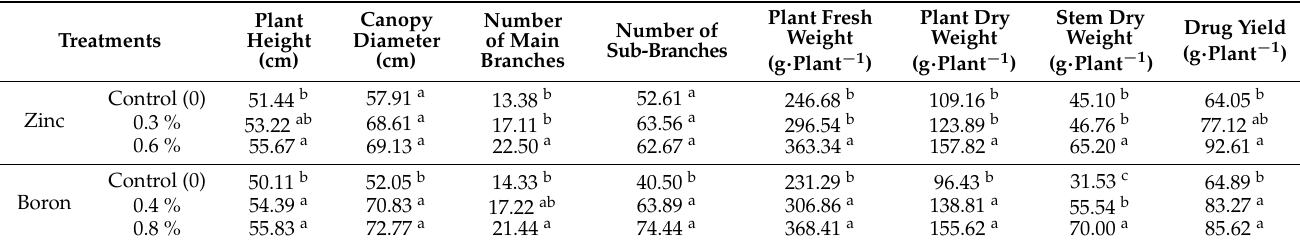
Table 3. Mean comparison of the simple effects of boron and zinc foliar application on biomass and yield attributes of S. khuzistanica in the second year of the experiment.